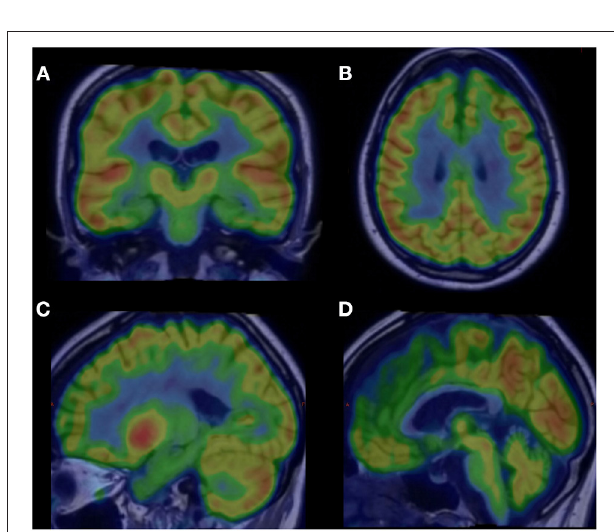
FIGURE 2 | 18F-FDG PET/CT slices exhibiting hypometabolism areas (green colored) in FTD: (A) hippocampus and mesial temporal lobes bilaterally (coronal slice); (B) medial frontal cortex/parafalcine region (axial slice); (C) precuneus and posterior cingulate cortex and (D) cerebellar vermis (sagittal